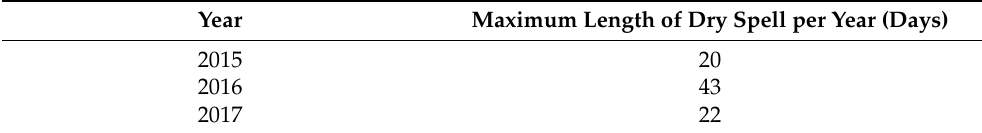
Table 2. Information of length of dry Spell in Chuping using MMD